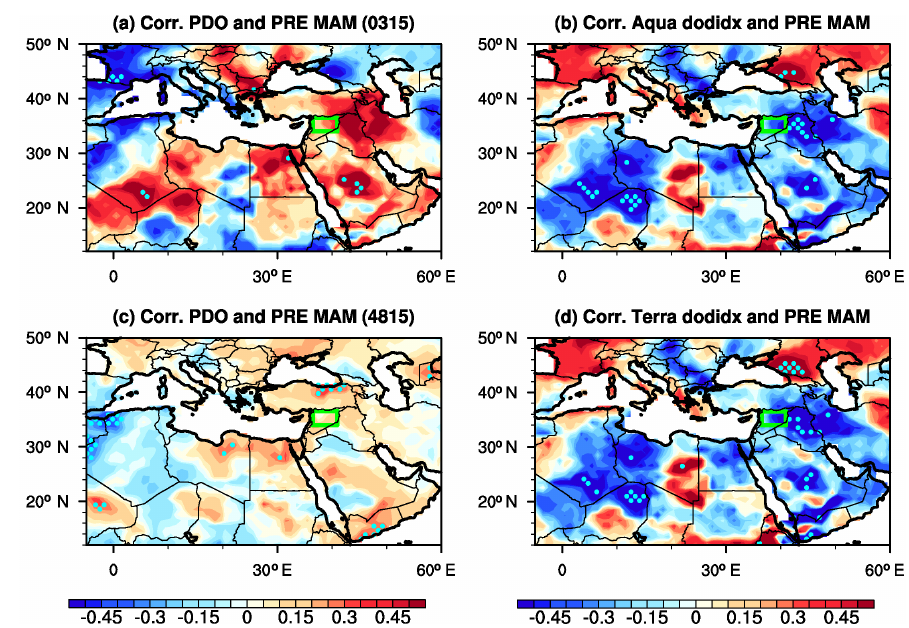
Figure 7. Correlation between PRECL precipitation and PDO index during (a) 2003–2015, (c) 1948–2015 and between precipitation and (b) Aqua and (d) Terra DOD indices during 2003–2015. Areas where the correlation coefficients are significant at the 95% confidence level ( t test) are dotted.